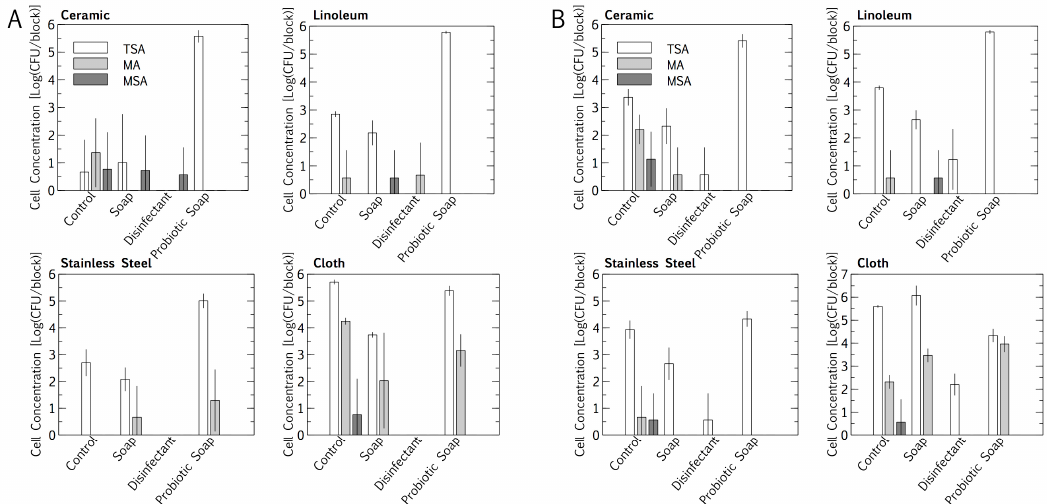
Figure 1. Impact of an eight-month cleaning regime (tap water control, plain soap, disinfectant, and probiotic cleaner) on microbial numbers of microbiomes on three surfaces, i.e., ceramic, linoleum and stainless steel, and on cloths used to wipe surfaces. Indoors ( A ) and outdoors ( B ) microbiomes are compared. The microbiome was assessed on tryptic soy agar (TSA, total), MacConkey agar (MA, Escherichia coli ), mannitol salt agar (MSA, Staphylococcus aureus ). Results are expressed as mean ± SD of four swab samples.